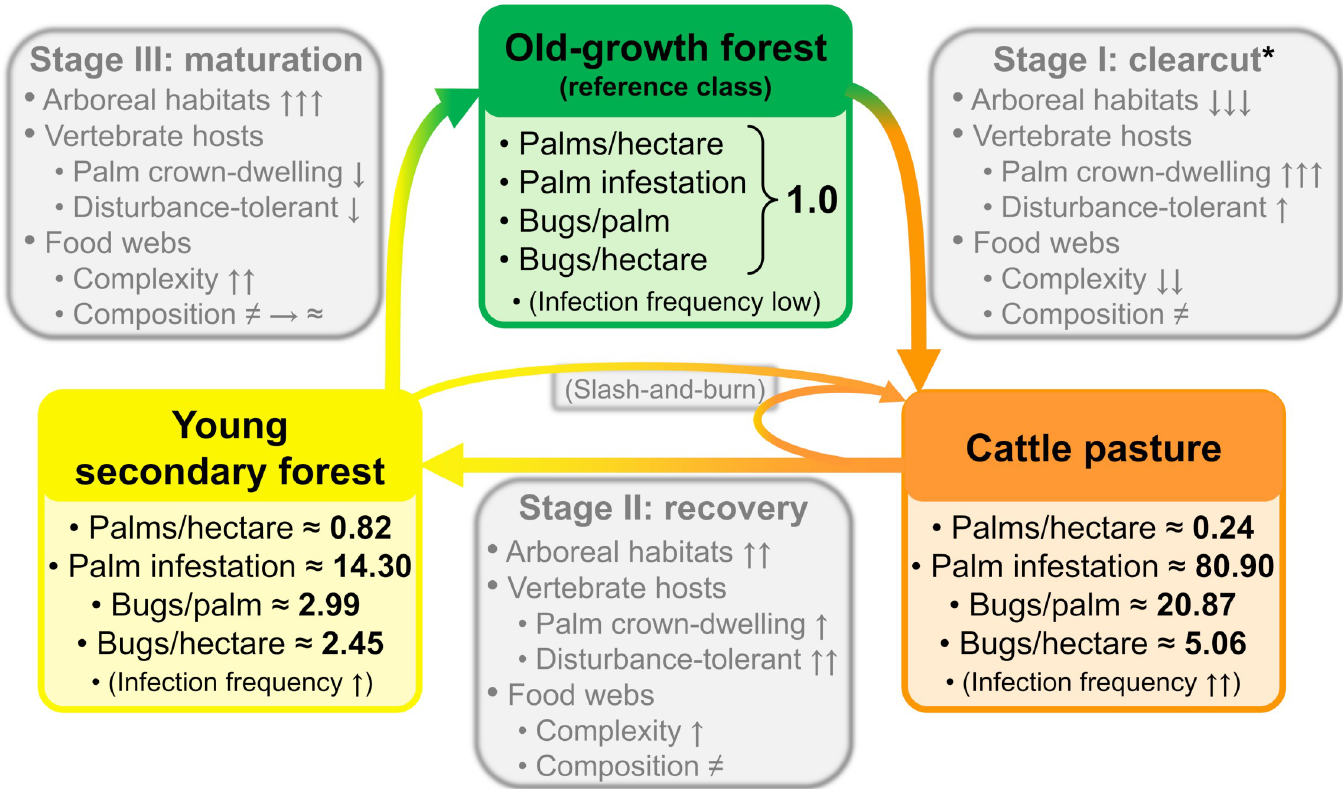
Fig 5. Effects of anthropogenic landscape disturbance on Attalea and Rhodnius spp.: A summary of results and hypotheses. The original old-growth forest (green box) is our “baseline” or “reference class”, and has therefore 1.0 values for all putative risk proxies (palms per hectare, palm infestation, and bug density per palm and per hectare; we could not quantify disturbance effects on vector-infection frequency). The right-hand-side grey box (“Stage I”) summarizes changes associated with transformation of old-growth forest into cattle pasture; note that some palms are usually spared during clearcut (hence the asterisk). The orange box summarizes changes, relative to old-growth forest, of our putative risk proxies. Cattle pasture is maintained through slash-and-burn; when abandoned, it recovers (“Stage II” box) into secondary forest. The yellow box again summarizes changes, relative to old-growth forest, of our putative risk proxies. If left undisturbed, secondary forests mature (“Stage III” box) into old-growth forests and the cycle is eventually completed. Note that the grey boxes show hypothetical processes (involving availability of arboreal habitats, vertebrate-host responses, and food-web features) that we suggest should be the focus of future research; the green, orange, and yellow boxes summarize the main results (presented as ratios–relative to old-growth forest) of the present study. See S1 Text for details.